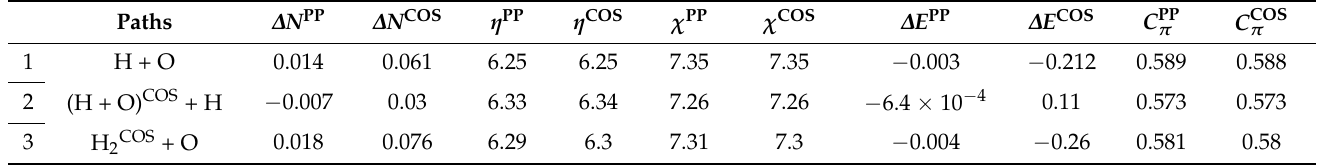
Table 5. The case of H 2 O molecule: the Parr–Pearson (PP) and chemical orthogonal space (COS) reactivity information, in terms of recursively computed charge transfer, exchanged energy, chemical hardness, electronegativity, and chemical power, according to formulations given in Table 1 and of Equation (13) for various add-atoms and add-bonding combinations. Paths